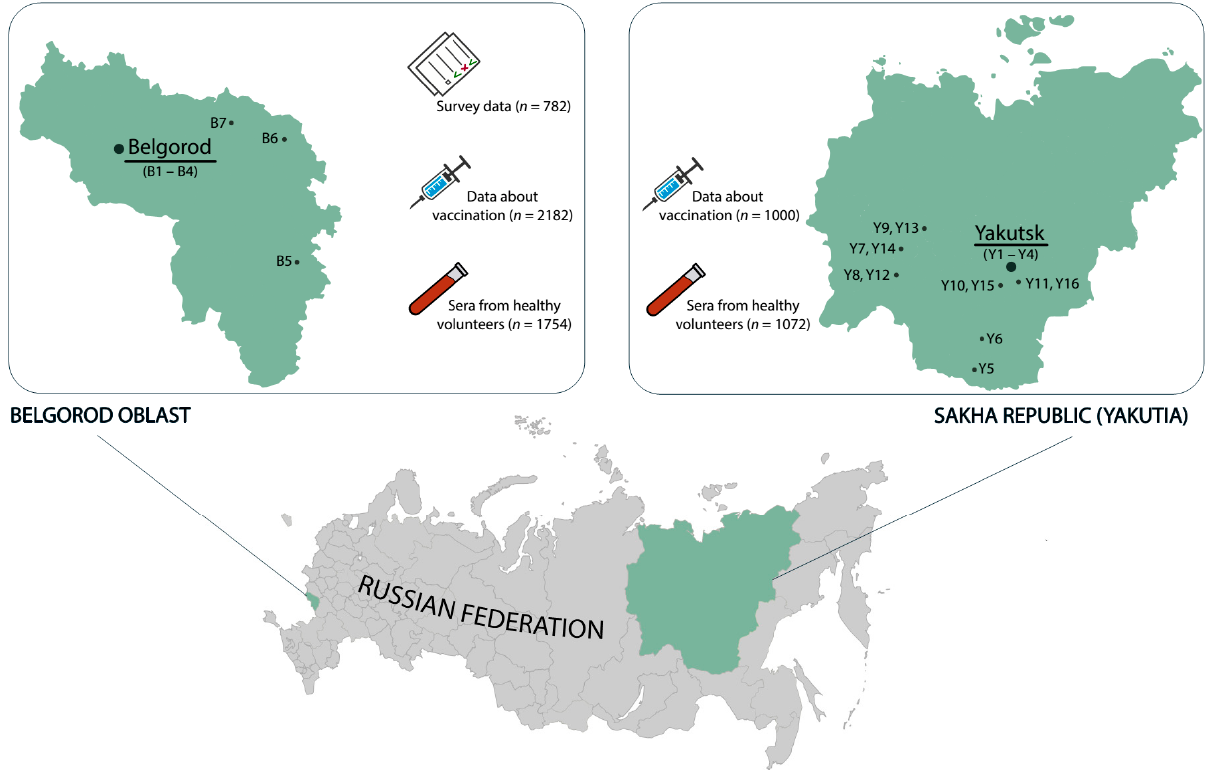
Figure 1. Study regions (in green) with indicated centers in each region where data on vaccination coverage were collected (B1 to B10–centers in Belgorod Oblast, Y1 to Y16–centers in Yakutia). The capital of each region is underlined. The number of participants in each step of the study (newborn vaccination coverage, serosurvey, survey of university students and teachers) are indicated in the callouts.